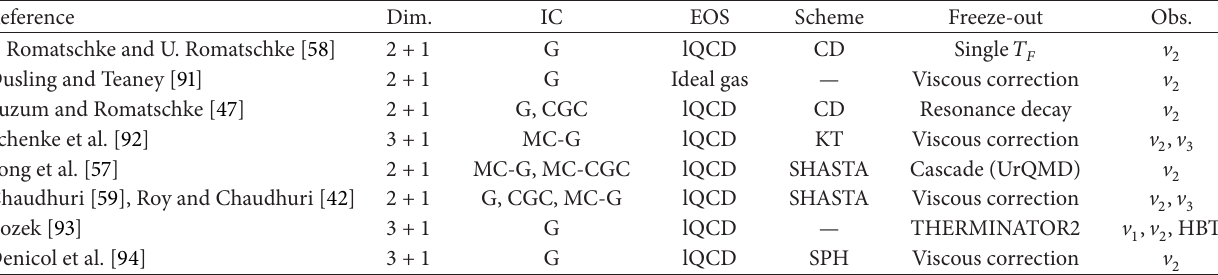
Table 1: Various viscous hydrodynamics models are listed.